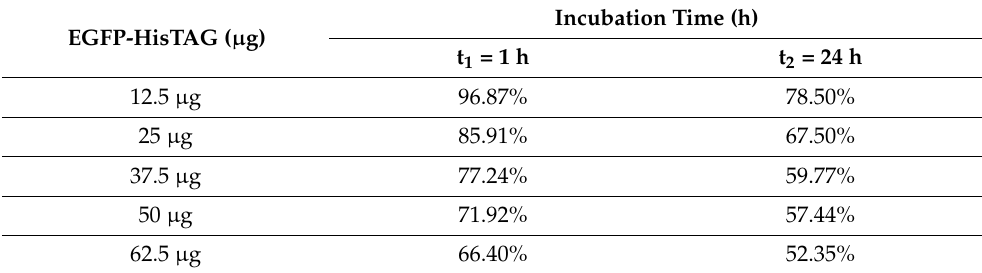
EGFP-HisTAG ( µ g)